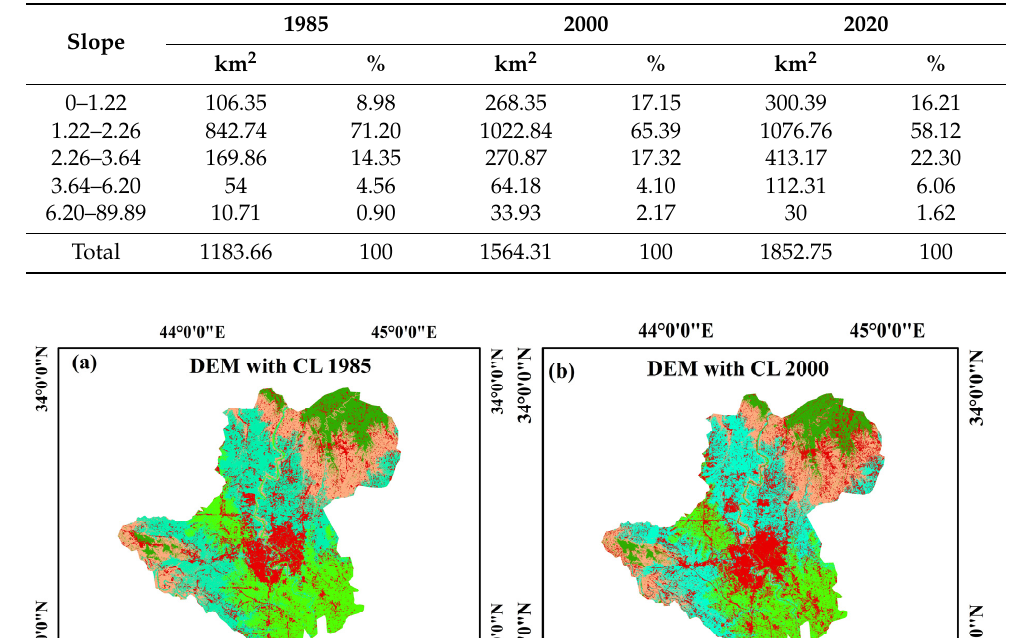
Table 7. Urban CL growth based on the slope (in degrees) from 1985 to 2020.